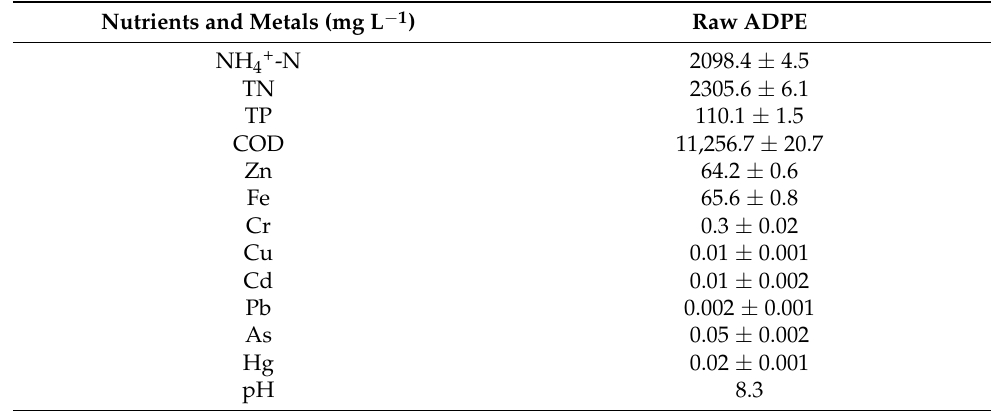
Table 1. Chemical composition of raw anaerobic digestion piggery effluents (ADPEs). The results are presented as arithmetic means ± standard deviations ( n =